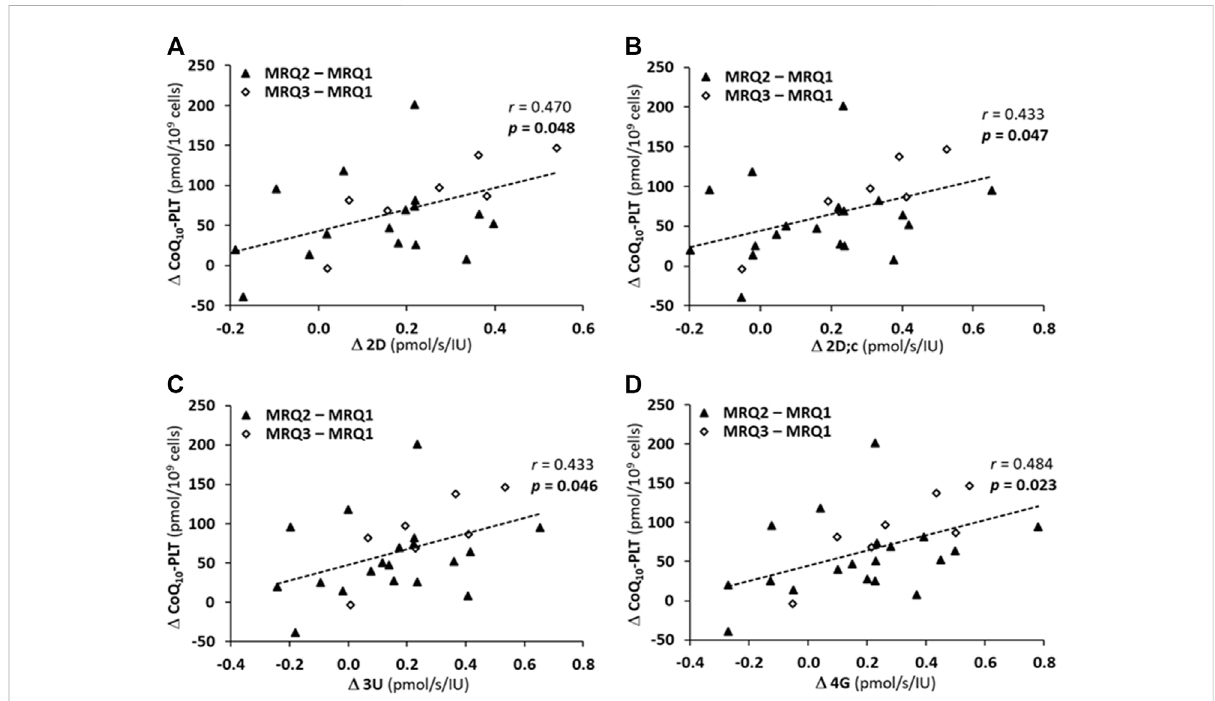
FIGURE 7 The correlations between an increase of CoQ10 concentration in platelets ( Δ CoQ10-PLT) and an increase in parameters of platelet mitochondrial respiration of patients of MRQ group (A) Δ 2D, (B) Δ 2D; c, (C) Δ 3U, (D) Δ 4G. The markers show the difference values between MRQ2 and MRQ1, and between MRQ3 and MRQ1 time points for each patient from MRQ group. The groups names and respiration rates labeling as for Figure 3. r — Pearson correlation coef fi cient; p -values show statistical signi fi cance of the